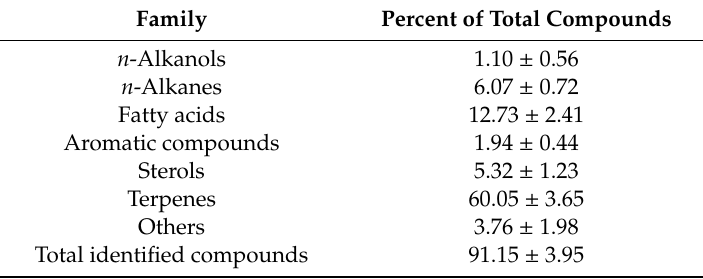
Table 2. Chemical class composition of the cuticular wax of leaves from six Quercus suber provenances, as a percentage of the total peak areas in the GC-MS chromatograms. Mean and standard deviation of 12 samples.